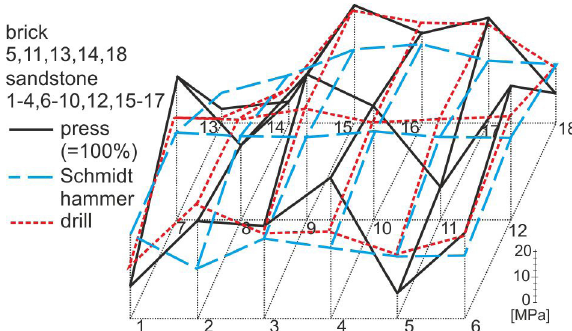
Fig. 8. The comparison of compressive strengths of masonry units obtained by non-destructive methods with those obtained by a press (100% = strength by a